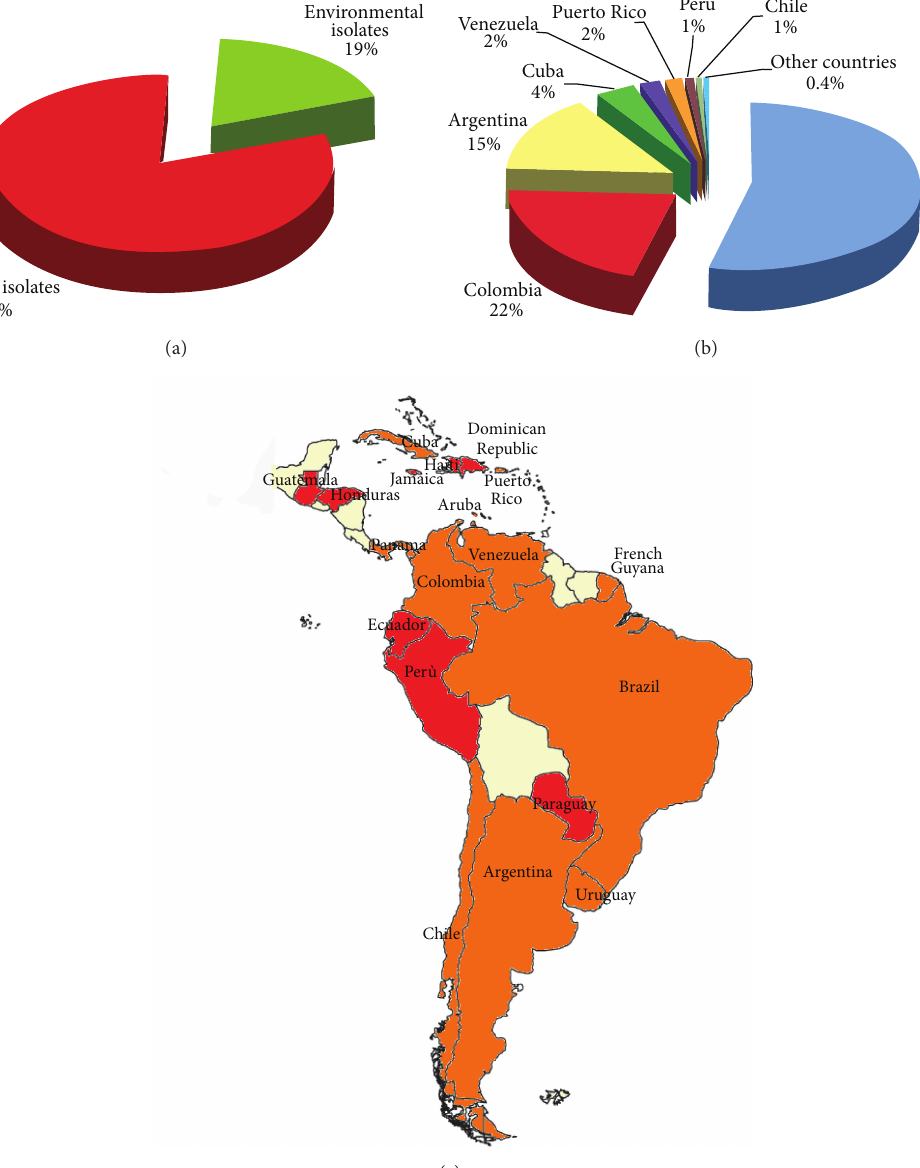
F 9: Percentage of Cryptococcus neoformans and Cryptococcus gattii isolates from clinical ( sources (a). Distribution of Cryptococcus neoformans and Cryptococcus gattii isolates in the different countries of Central and South America (b). Map of the geographical distribution of the Cryptoccocus neoformans and Cryptococcus gattii isolates in Central and South America (c). Clinical isolates were reported from red-coloredcountries, whereas both clinical and environmental isolates were reported from orange- colored